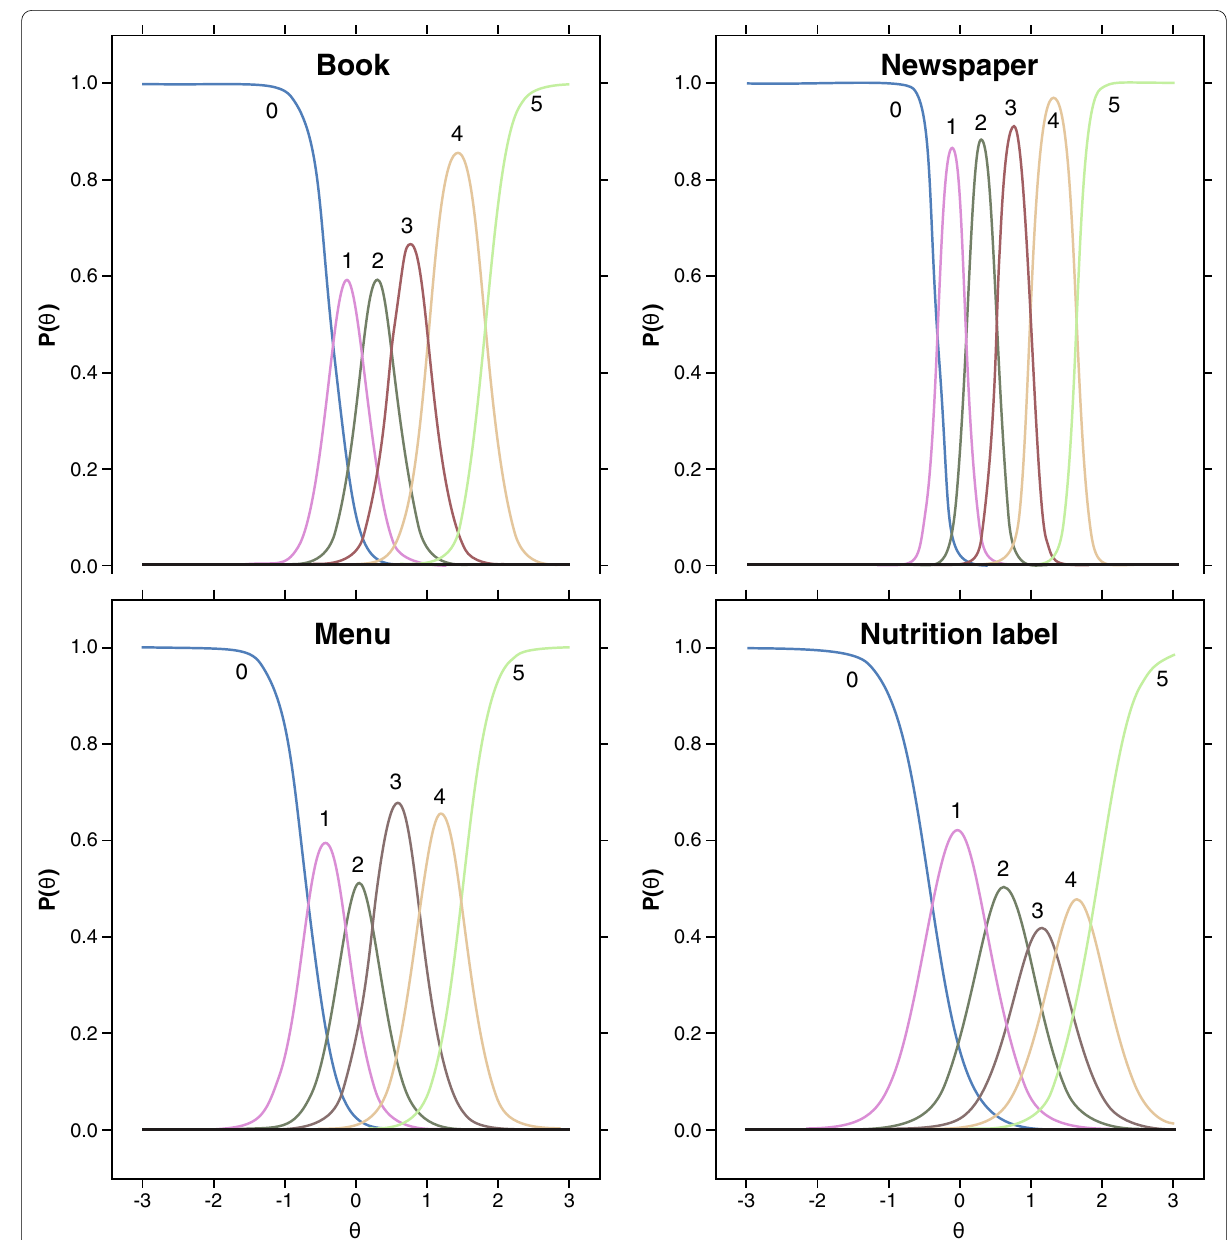
Fig. 3 Graded item characteristic curves for the Performance correspond to the testlet responses as defined in Table